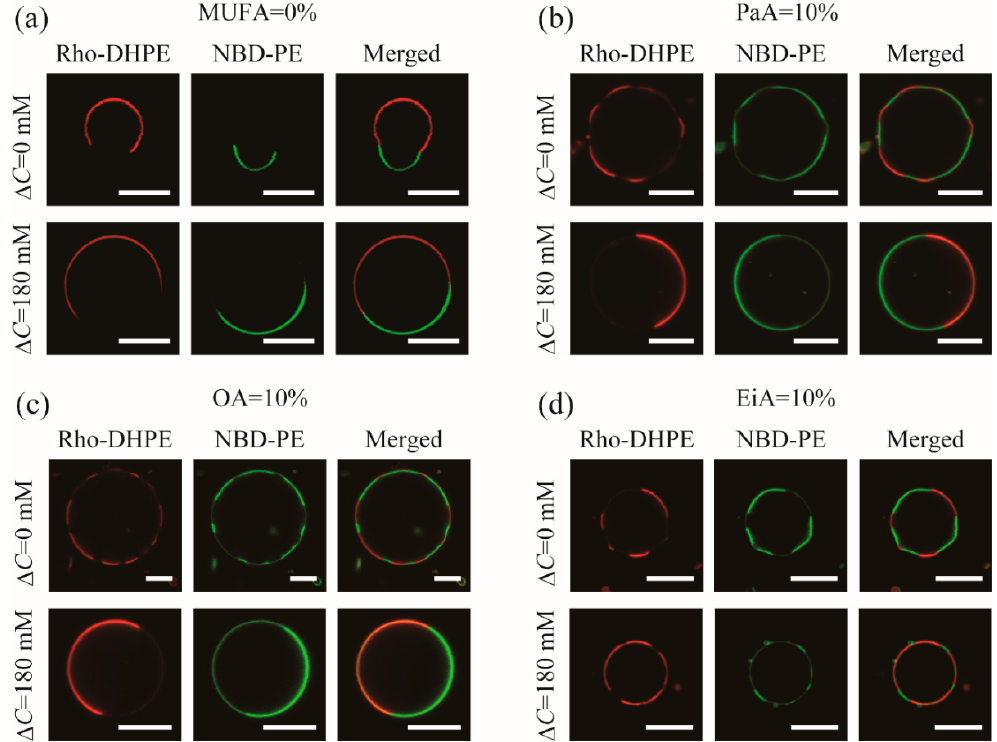
Figure 3. Phase-separated vesicles observed by confocal laser scanning microscopy for ( a ) DOPC/DPPC/MUFA/Chol = 40/40/0/20, ( b ) 30/40/10/20 (MUFA = PaA), ( c ) 30/40/10/20 (MUFA = OA), and ( d ) 30/40/10/20 (MUFA = EiA) at Δ C = 0 (without osmotic stress) and 180 mM (with osmotic stress). The red and green colors correspond to Rho-DHPE and NBD-PE, respectively. Scale bars are 10 μ m.